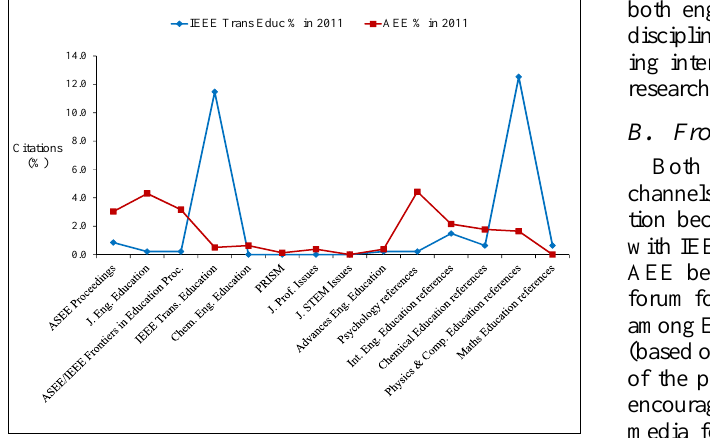
Figure 6. Extended citation analysis of the 2 journals in